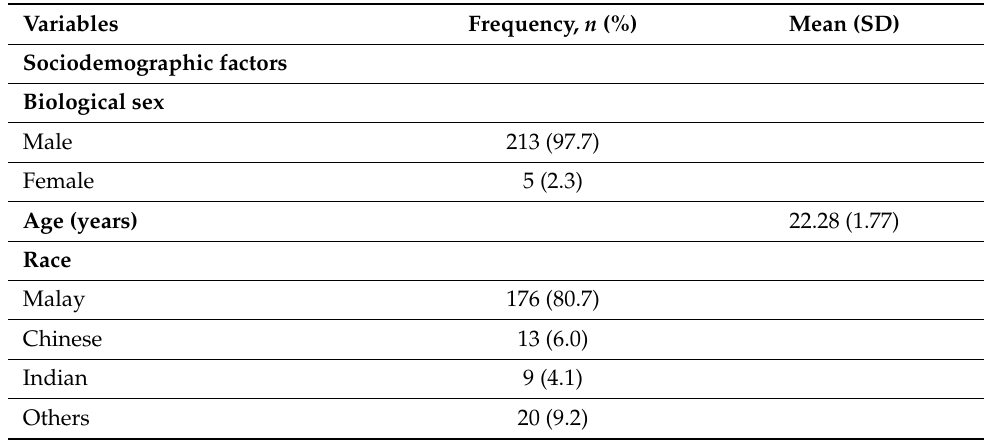
Table 1. Sociodemographic, clinical and sexual factors of the participants, n =